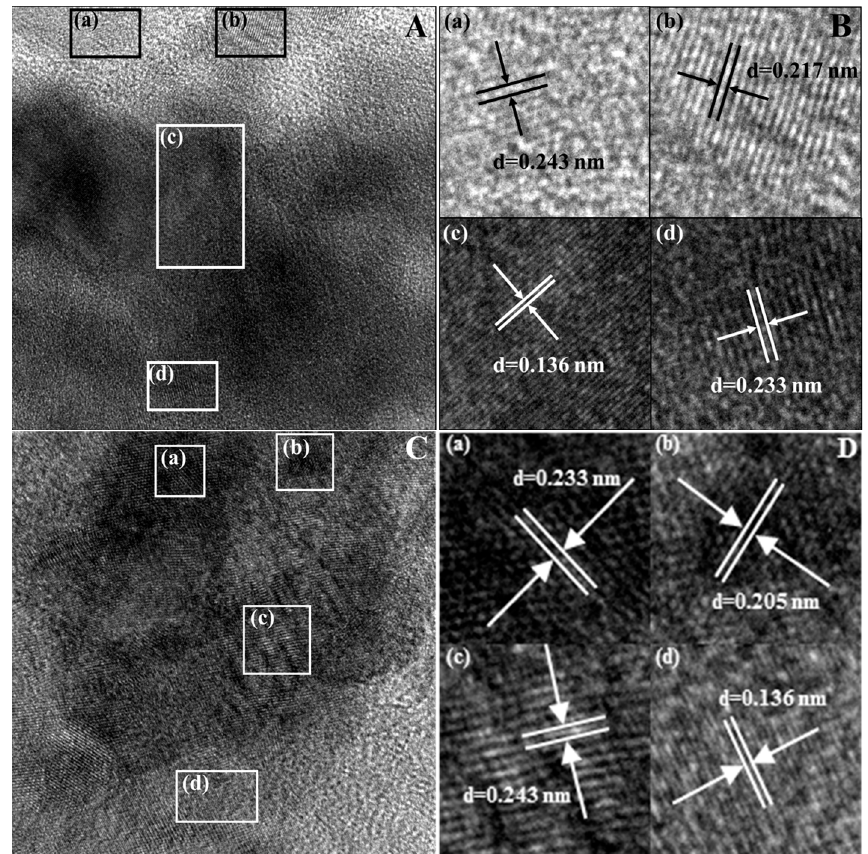
Figure 1. High-resolution transmission electron microscopy (HRTEM) images of layered double hydroxide (LDH) ( A , B ) and nanodiamond/layered double hydroxide (ND/LDH) ( C , D ). ( a – d ) are the four kinds of selected lattice fringes for LDH and ND/LDH, respectively.